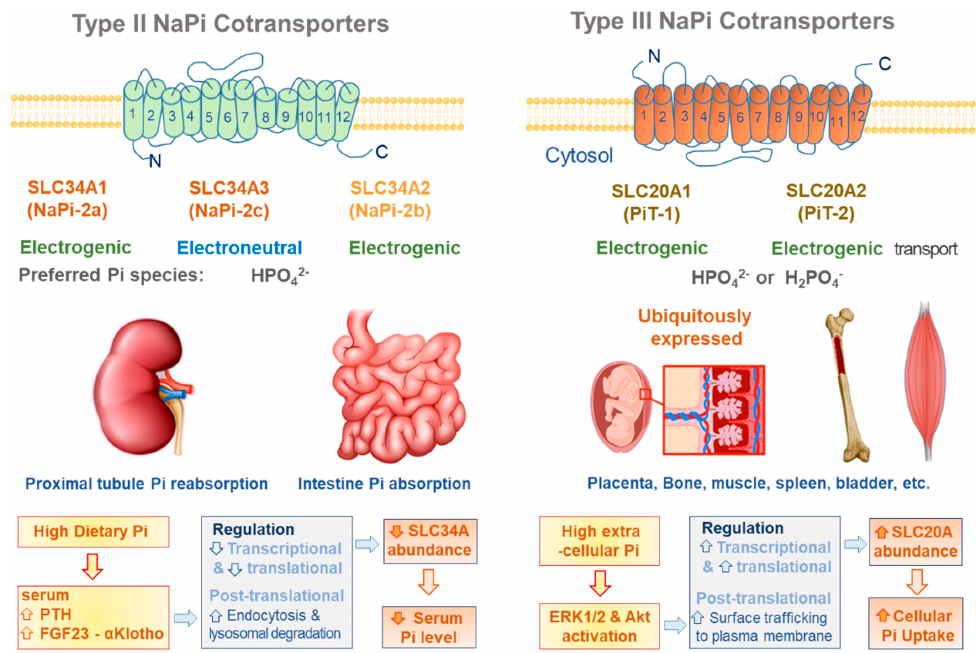
Figure 1. Plasmalemmal Pi transporters. The characteristics and tissue expressions of type II and III NaPi cotransporters are illustrated. The functional abundance of type II NaPi cotransporters are regulated by hormones, such as PTH and FGF23, in order to normalize serum Pi levels upon the alterations in dietary Pi. However, high extracellular Pi directly increases the functional abundance of type III NaPi cotransporters, leading to intracellular Pi accumulation.